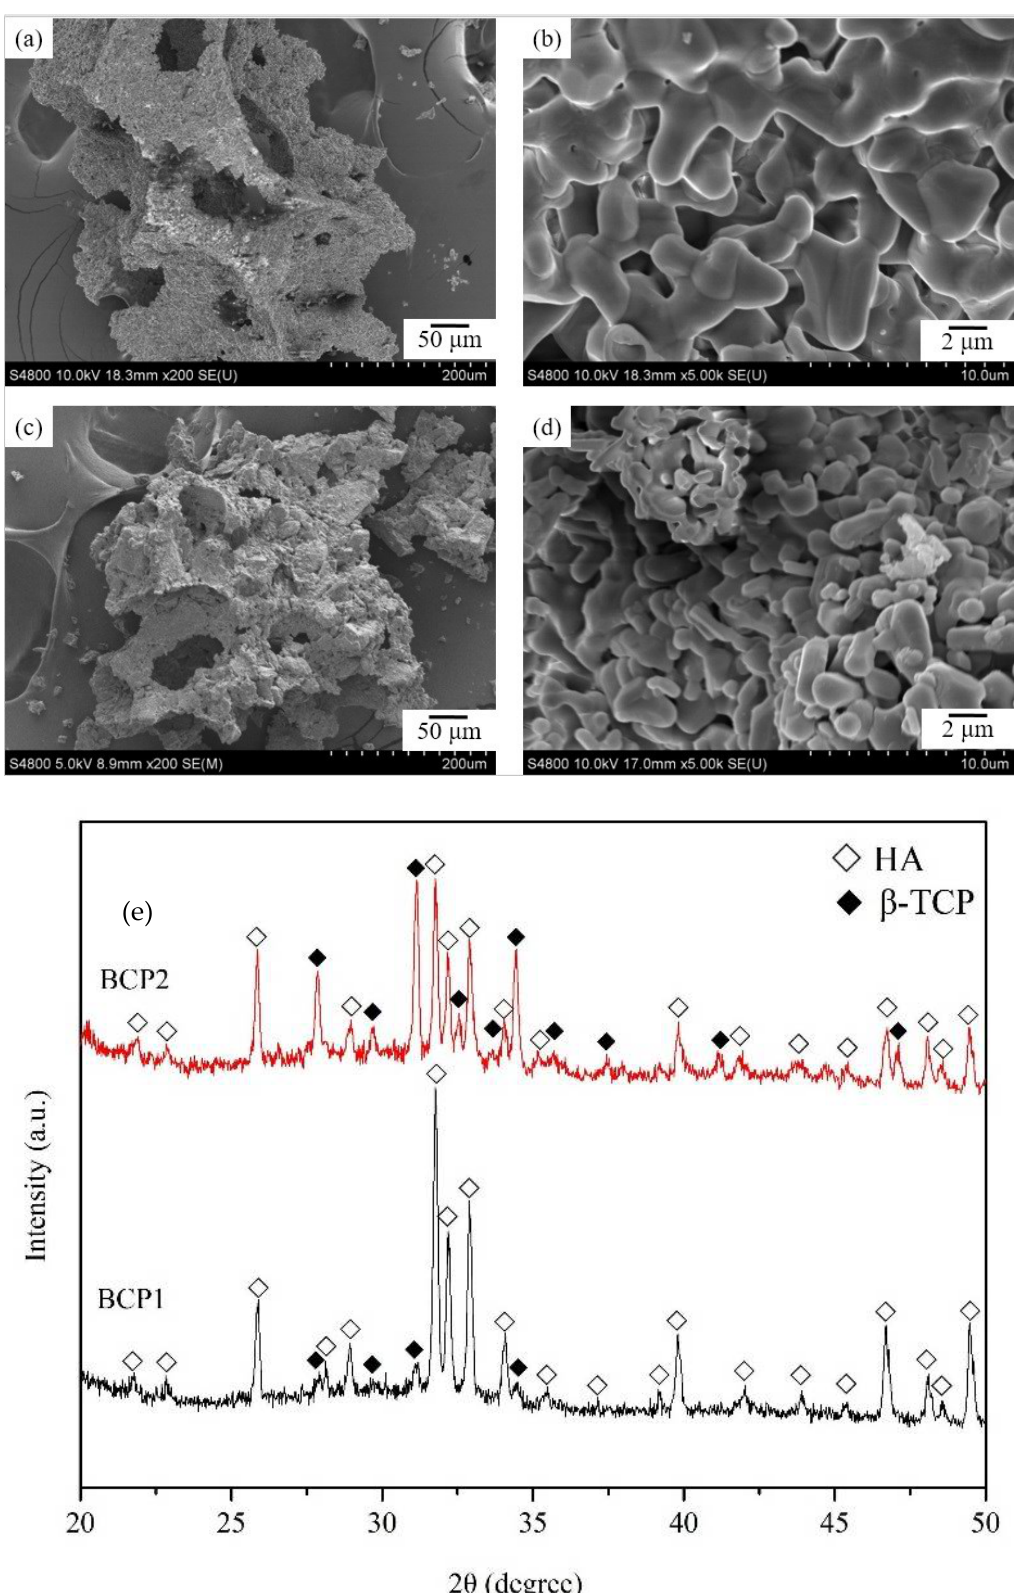
Figure 1. FE-SEM images of BCP1 ( a , b ) and BCP2 ( c , d ) granules; ( e ) XRD patterns of BCP1 and BCP2 granules.